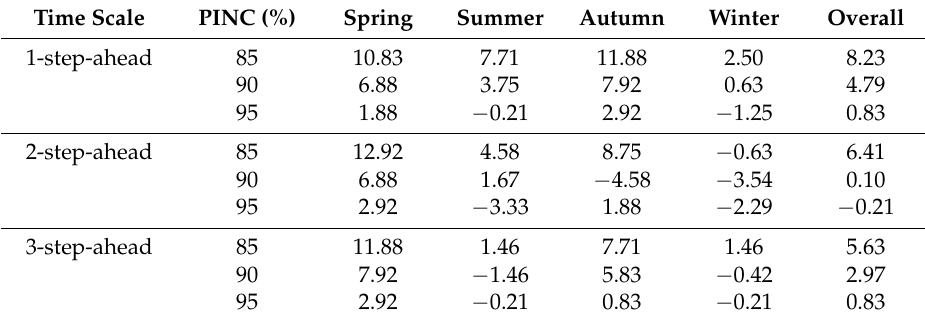
Table 5. The criterion ACE (%) of probabilistic wind speed forecasting using WTD-RNN-ANFIS. Time Scale PINC (%)